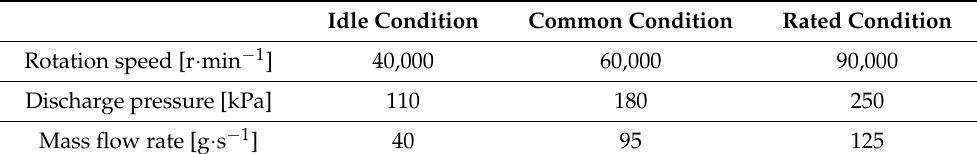
Table 3. Operating conditions.